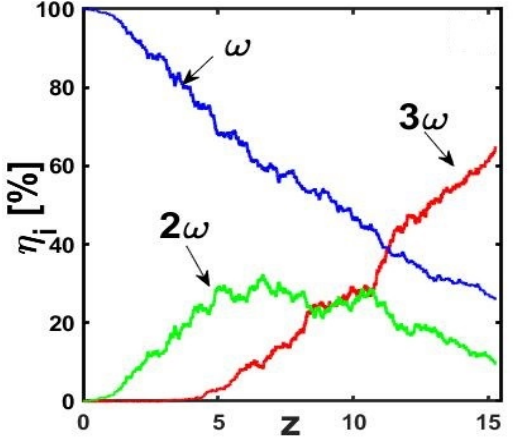
Figure 2. Results of the numerical experiments after 5000 iterations in a dimensionless quadratic sample. Normalized intensities at the three frequencies along the propagation length when the QPM lattice has (see, e.g., Figure 1a) differently sized domains in each segment.